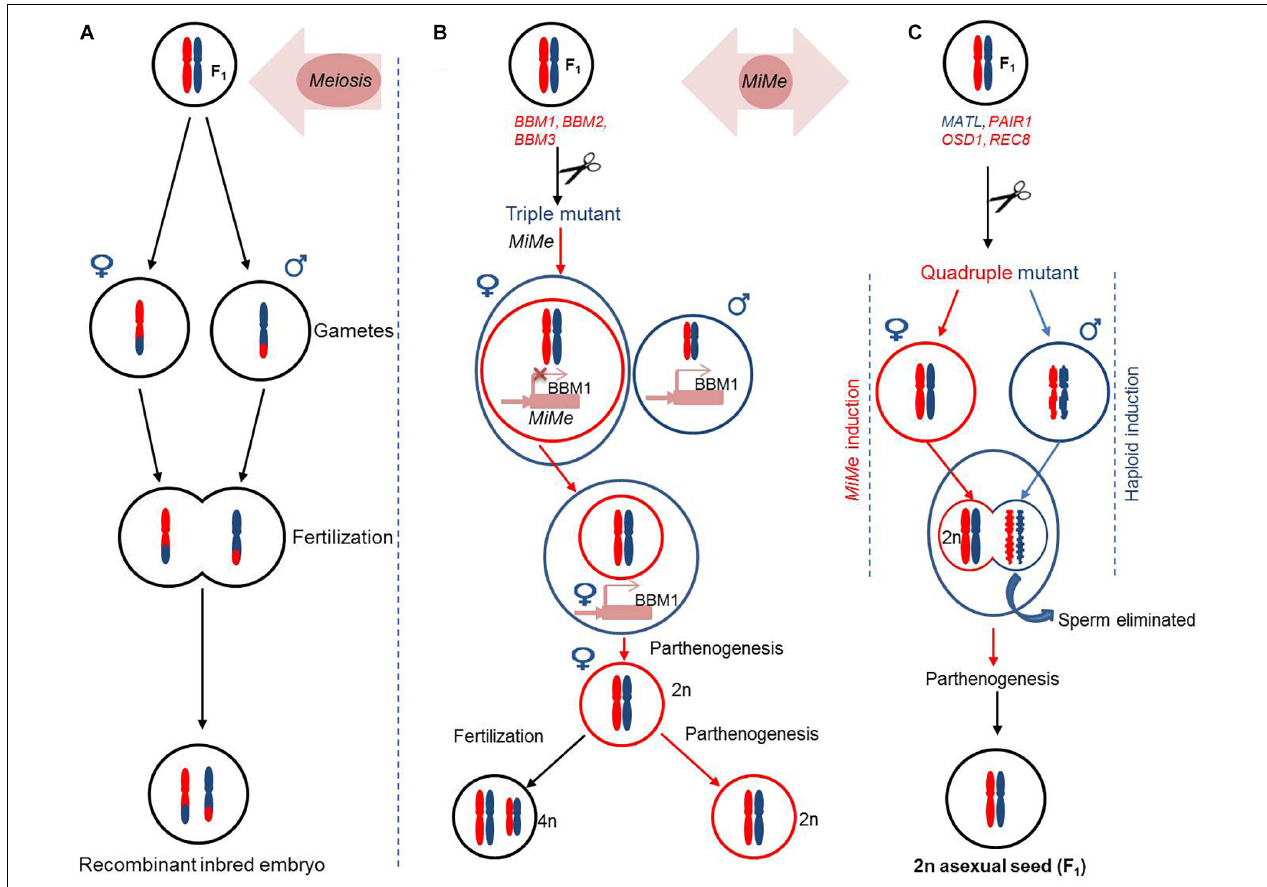
FIGURE 8 | Work flow for synthetic apomixes in rice. (A) Normal meiosis process promotes segregation and produces recombinant inbred embryo. (B) Triple mutant of BBM1 , BBM2 , and BBM3 triggers MiMe and causes embryo abortion during early fertilization in ovary, which can be rescued by male-transmitted BBM1 to produce asexual 2n seeds through parthenogenesis. (C) Triple mutant of PAIR1 , OSD1 , and REC8 promotes MiMe phenomenon to avoid fertilization. The MATL in quadruple mutant of MATL , PAIR1 , OSD1 , and REC8 promotes haploid production by eliminating parental chromosomes during fertilization and facilitates parthenogenesis to produce 2n asexual clonal seeds. MiMe , mitosis instead of